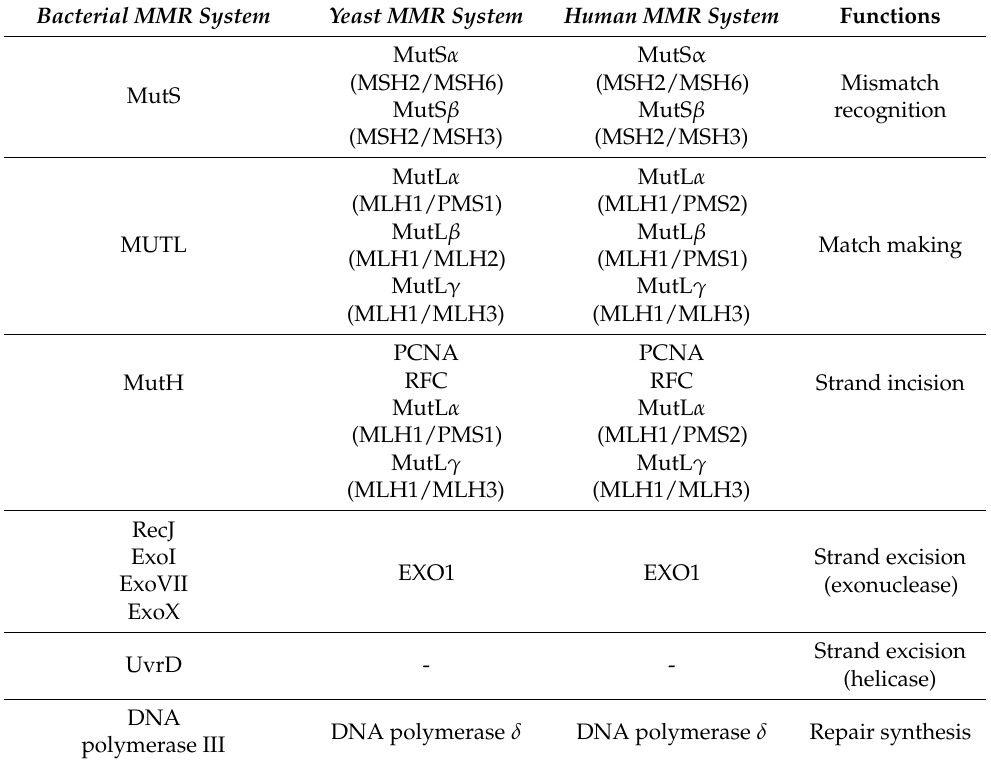
Table 2. MMR proteins and their